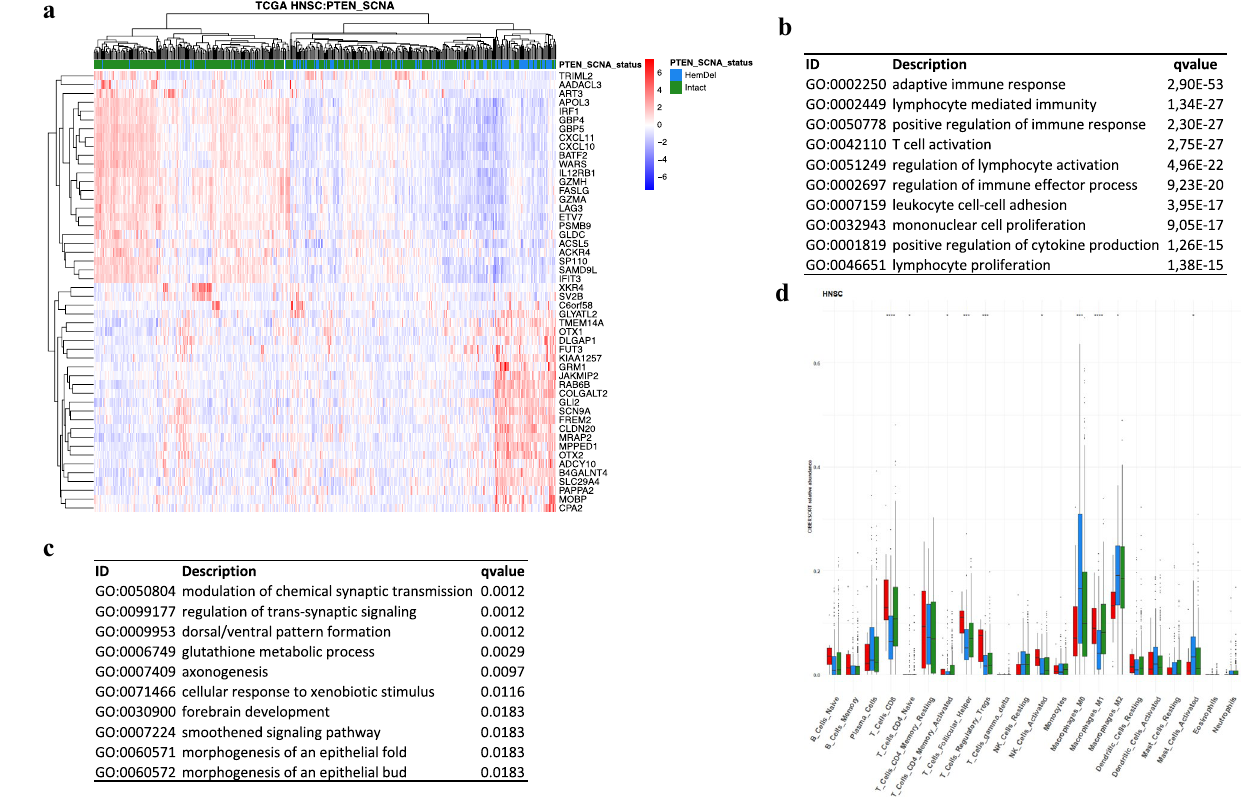
Figure 5. PTEN HemDel in head and neck squamous cell carcinoma (HNSC) shows distinct transcriptome activity. ( a ) Transcriptome heatmap exhibiting clustering of top 50 DEGs (Log2Fold change > 0.58). The color scale in the heatmap represents the Z-score of the normalized read counts for each gene, where the red scale color indicates upregulated, and blue low expressed genes. Enrichment analyses were performed using clusterProfiler and p -adjusted value = 0.05 as the cutoff. ( b ) Enriched GO (BP) pathways of the upregulated genes. ( c ) Enriched GO (BP) pathways of the downregulated genes. The tables shown in ( b ) and ( c ) indicate the top 10 most significant Gene Ontology (BP) terms. ( d ) CIBERSORT ‐ derived immune ‐ cell abundance of 22 distinct cell subsets based on PTEN status and head and neck tumors. Y ‐ axis shows CIBERSORT relative scores. PTEN HemDel in head and neck tumors was linked to higher M0 and M2 macrophages, mast cells, and lower CD4 T, CD8 T, T regs, and NK cells. * p -value < 0.05; ** p -value < 0.01, by Mann–Whitney test. n = 492. DC dendritic cell; NK natural ‐ killer cell; PCa prostate cancer; Treg regulatory T cell; M0 M0 macrophage; M1 M1 macrophage; M2 M2 macrophage. Plotted using pheatmap (https:// rdocu menta tion. org/ packa ges/ pheat map/ versi ons/1. 0.